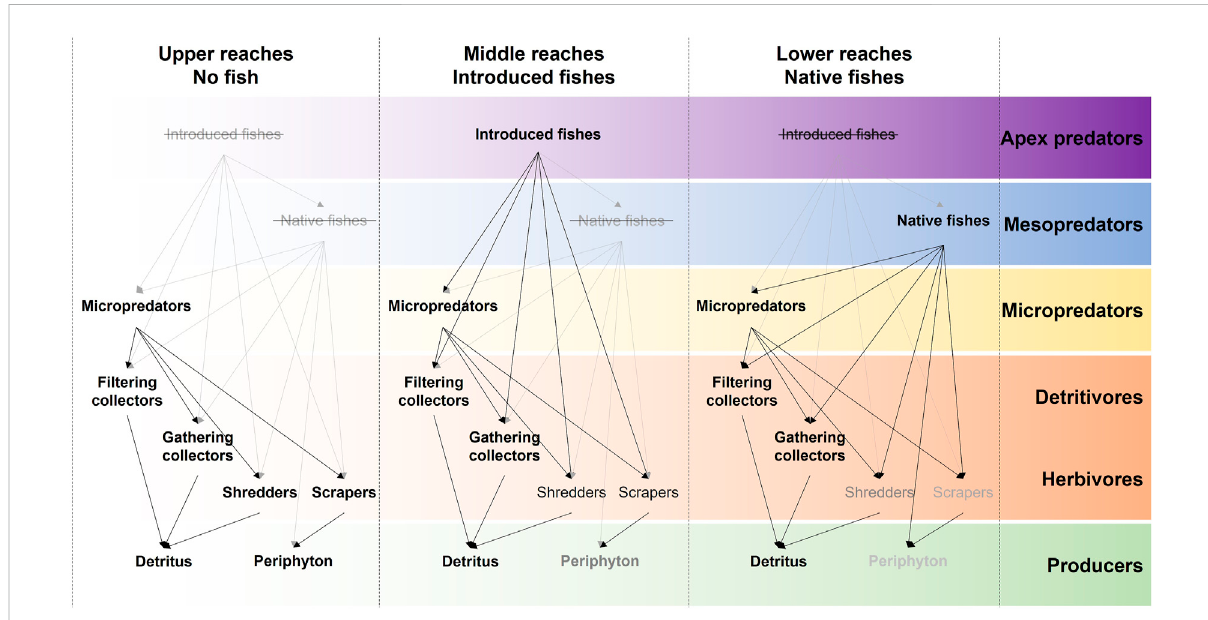
FIGURE 1 Postulated trophic web of theupper Keiskamma river system. The top-down trophic cascade of predators isbased on observations byEllender (2014) andEllender &Weyl(2014).The distributionof fi shesbetweenmiddle andlower reachesfollowsEllender etal. (2016).Thebottom-uptrophic